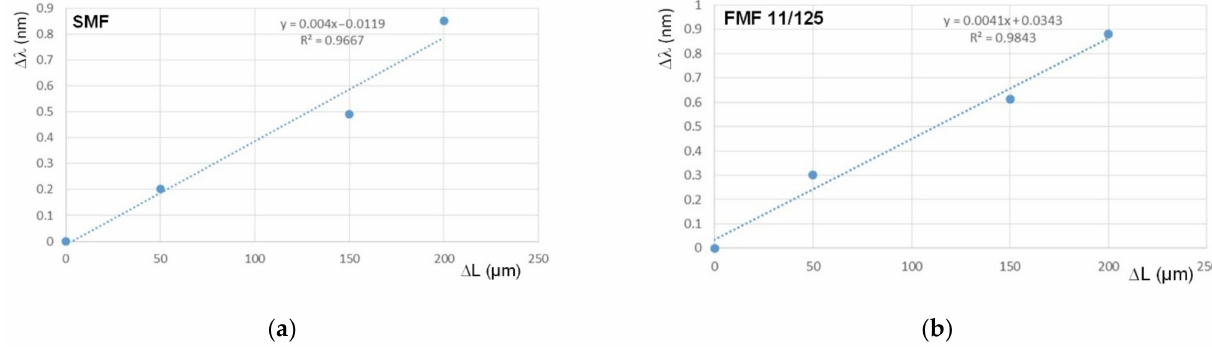
Figure 11. FBG Bragg wavelength λ B shifting sensitivity to the mechanical action: ( a ) FBG on SMF; ( b ) FBG on FMF